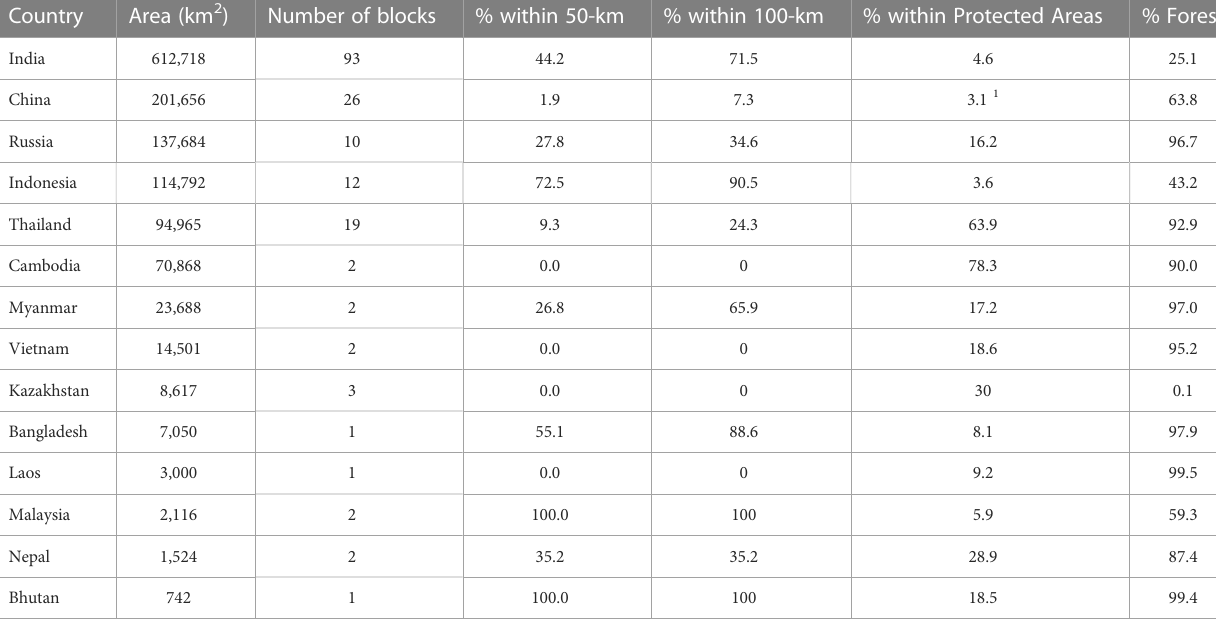
TABLE 1 Range expansion area (km 2 ) per country plus the number of discrete blocks of habitat and the percentage of expansion area within 50-km and 100-km of current tiger distribution, the percentage within Protected Areas, and the percentage classi fi ed as Forest ( SI Table 2 ).